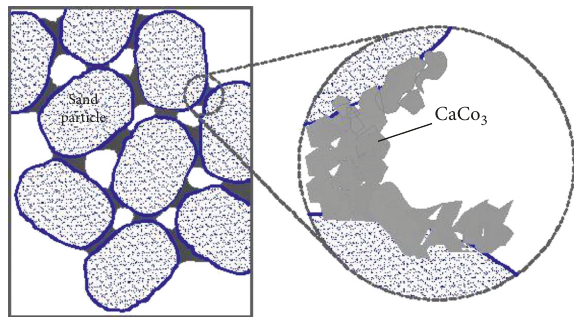
Figure 10: Schematic of sand particles encapsulated by CaCO